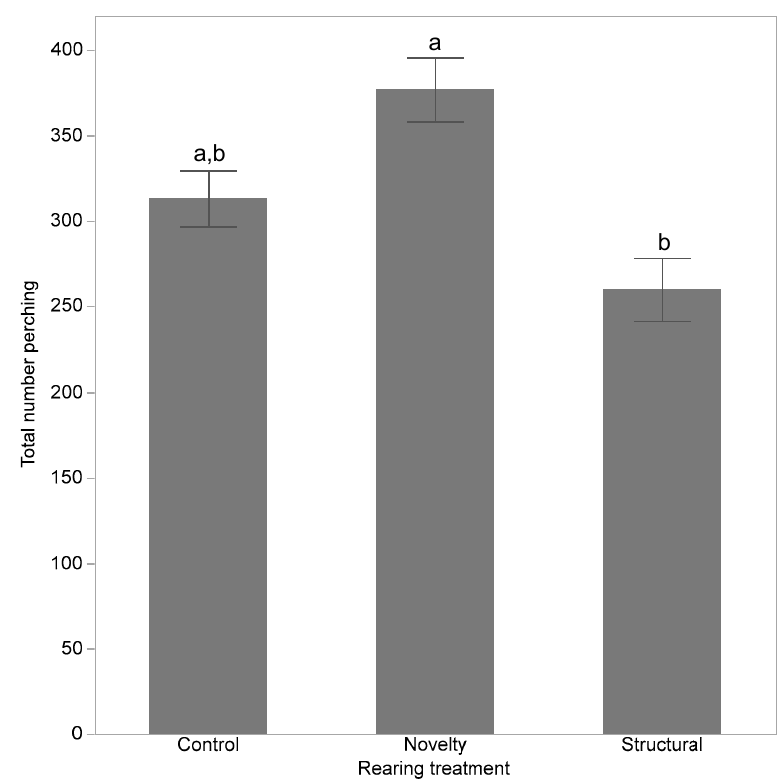
Figure 3. The total number of birds observed perching within the pen across the day for pullets exposed to three rearing enrichment treatments (control, novelty, structural). a,b Dissimilar letters indicate significant differences between rearing treatments.